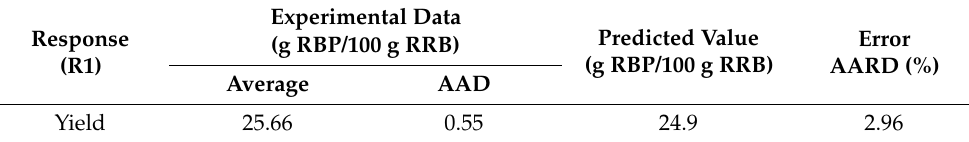
Table 1. Model validation with experimental data.